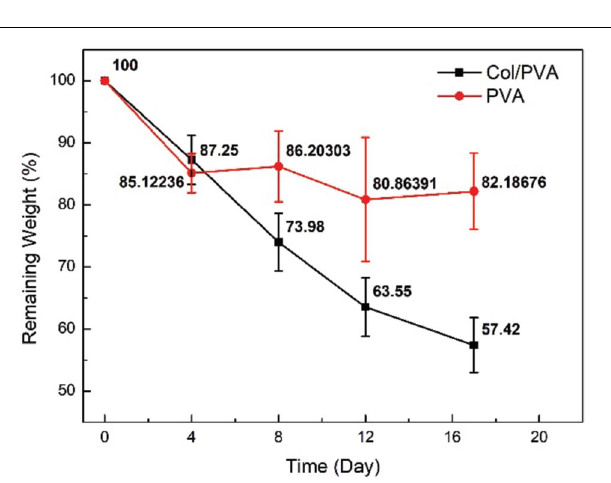
FIGURE 3 | Remaining weight of Col/PVA and PVA membrane after being immersed in PBS for different time